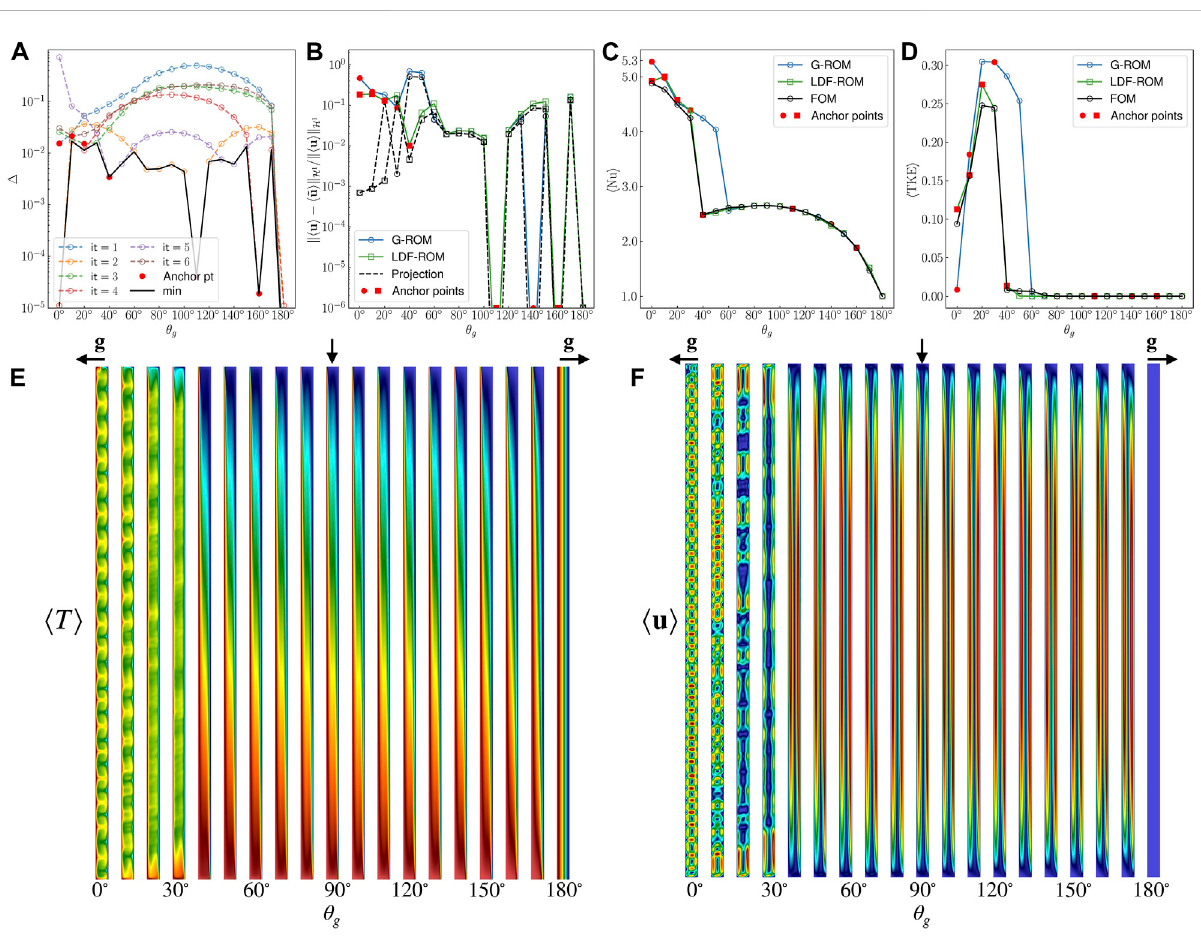
FIGURE 4 POD- h Greedy performance comparisonbetweenG-ROM and LDF ROM for theparametric problem parameterizedwith θ g atRa= 8× 10 4 and Pr = 7.2. (A) Behavior of the error indicator Δ de fi ned in Eq. 44 for six iterations with LDF-ROM. (B – D) Behavior of the relative H 1 error in predicted solution, meanNu,andmeanTKEwith θ g basedonsixanchorpoints. ( N =100at θ g =0 ° ,20 ° , N =80at θ g =10 ° ,30 ° ,40 ° , N =1at θ g =110 ° ,140 ° ,160 ° ). (E,F) Mean (or steady) temperature and velocity solution for 19 uniformly spaced θ g ∈ [0 ° , 180 °